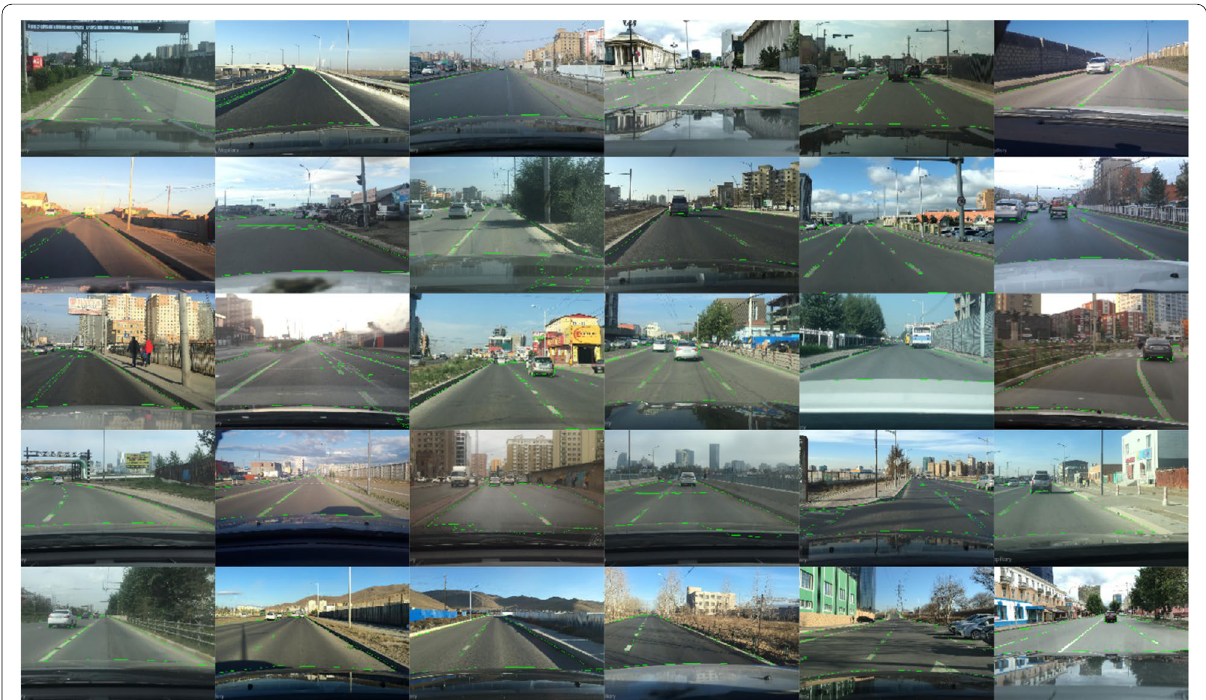
Fig. 27 Roadway images with high condition